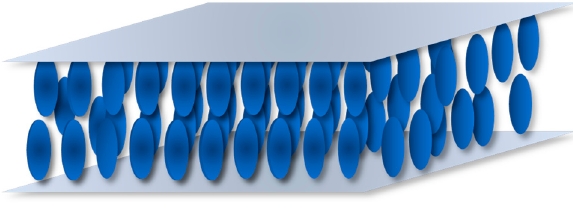
Figure 1. Homeotropic alignment in a nematic LC cell.